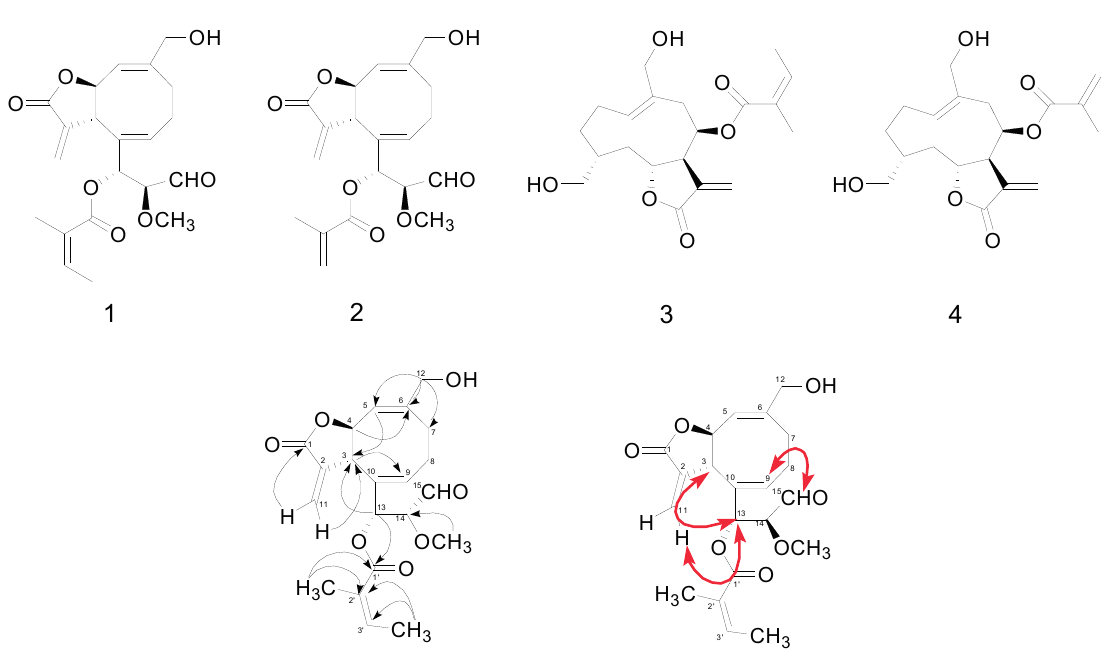
Figure 1. Chemical structures of compounds 1 – 4 and key HMBC ( → ) and NOESY (bold ↔ ) correlations for compound 1